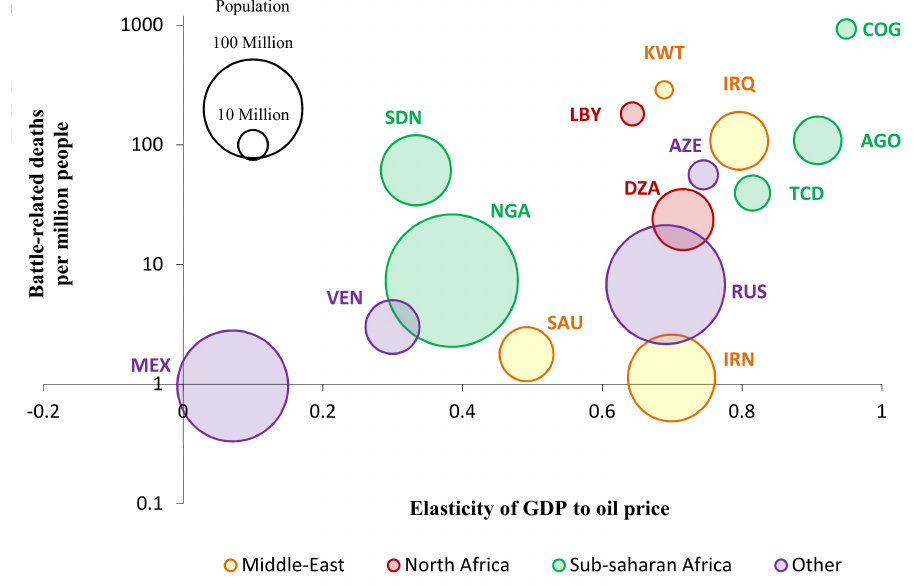
Figure 11. Relation between the exposure of macroeconomic performance to the oil price and battle-related deaths per million people (1990–2014). Size of the bubbles indicates population size in 2014. Data source: own estimates and